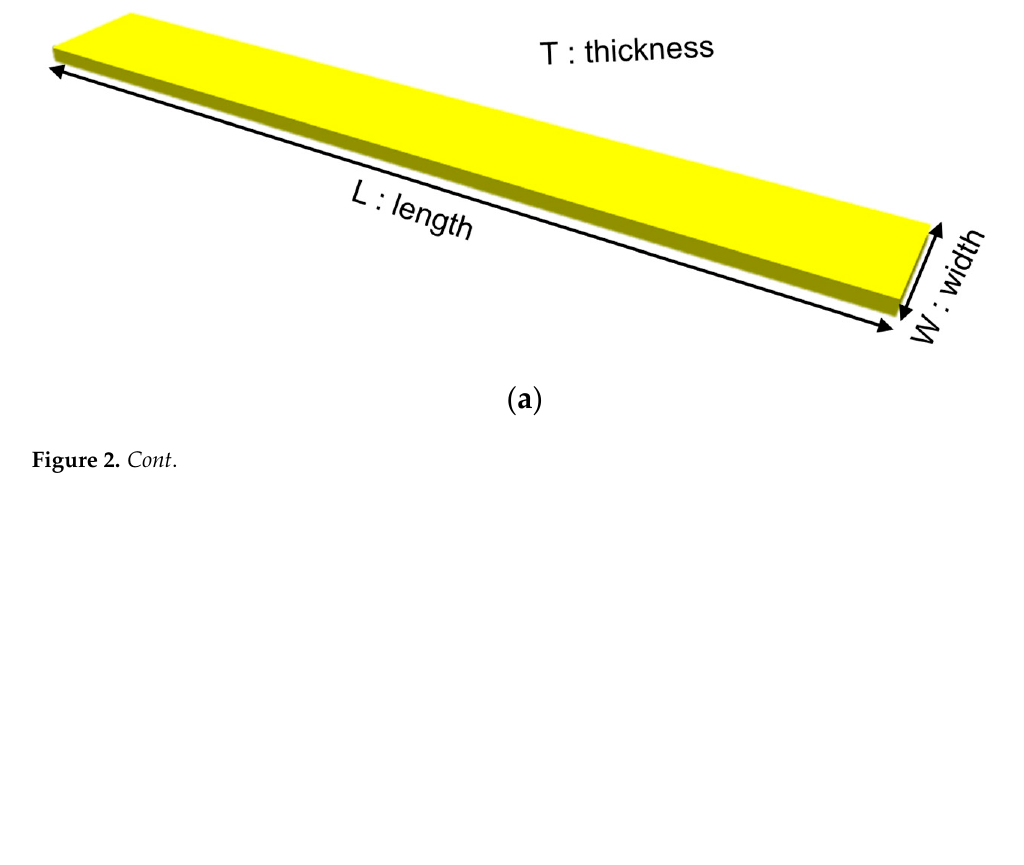
Figure 1. Concept of implantable biocompatible packaging. ( a ) Overall view. ( b ) Enlarged view of the feedthrough of the layered polymer package (dotted rectangle in red color in ( a )).